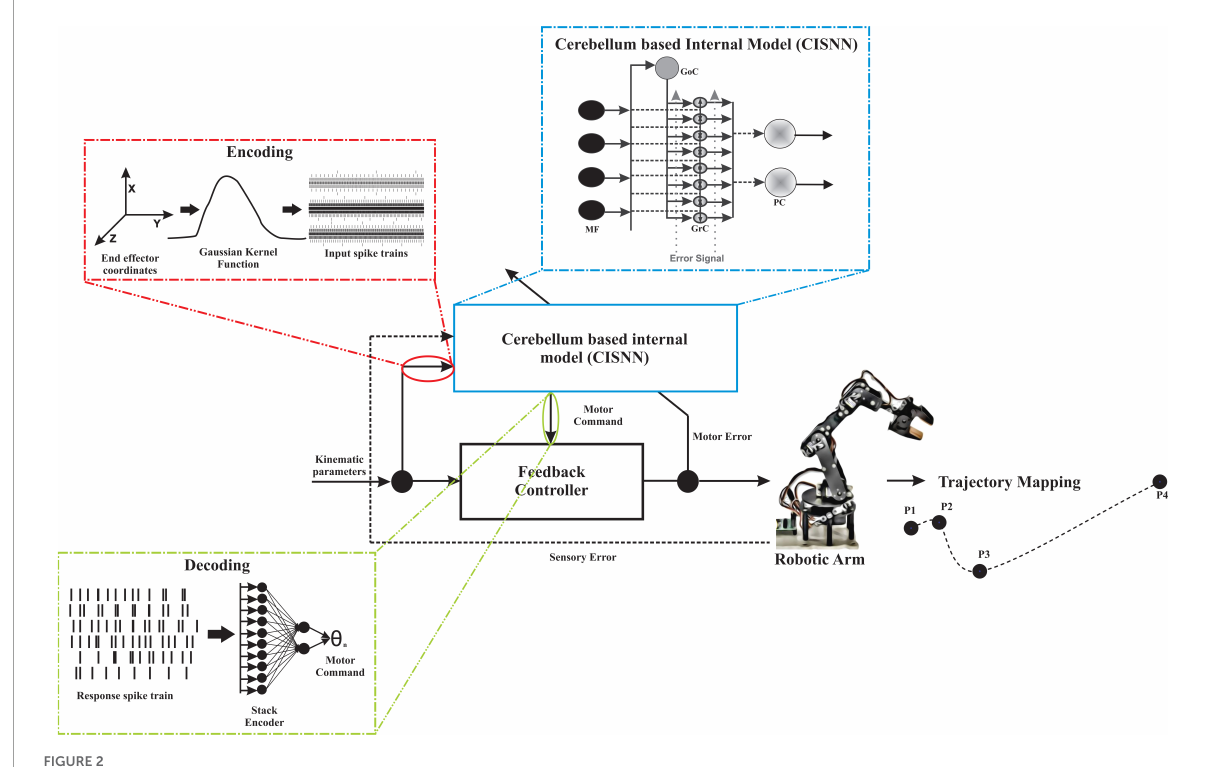
FIGURE2 The network topology for robotic abstraction to predict trajectory. Input parameters (kinematic parameters) were encoded to MF spike times using a Gaussian kernel and are temporal coded. The temporal coded information is given as input to the cerebellum-inspired spiking neural network (CISNN). CISNN is a layered network with MF, GrC, and PC layers. The output of CISNN was obtained as PC spike times which were then rate coded by employing a stack encoder, the output obtained was presented to a low-cost robotic articulator that mapped the 4-point trajectory. Changes in sensory and motor values were calculated and fed back to the network to learn and update the existing weights.